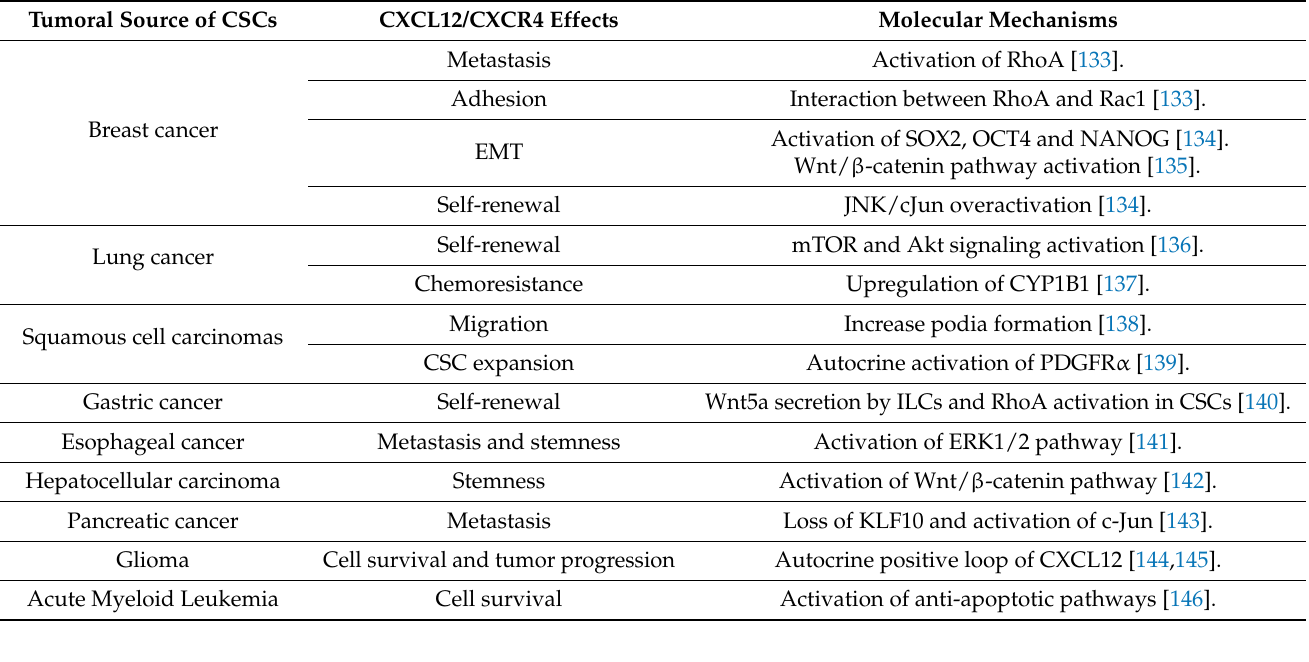
Table 1. Effects of the CXCL12/CXCR4 axis in CSCs and their molecular mechanisms.